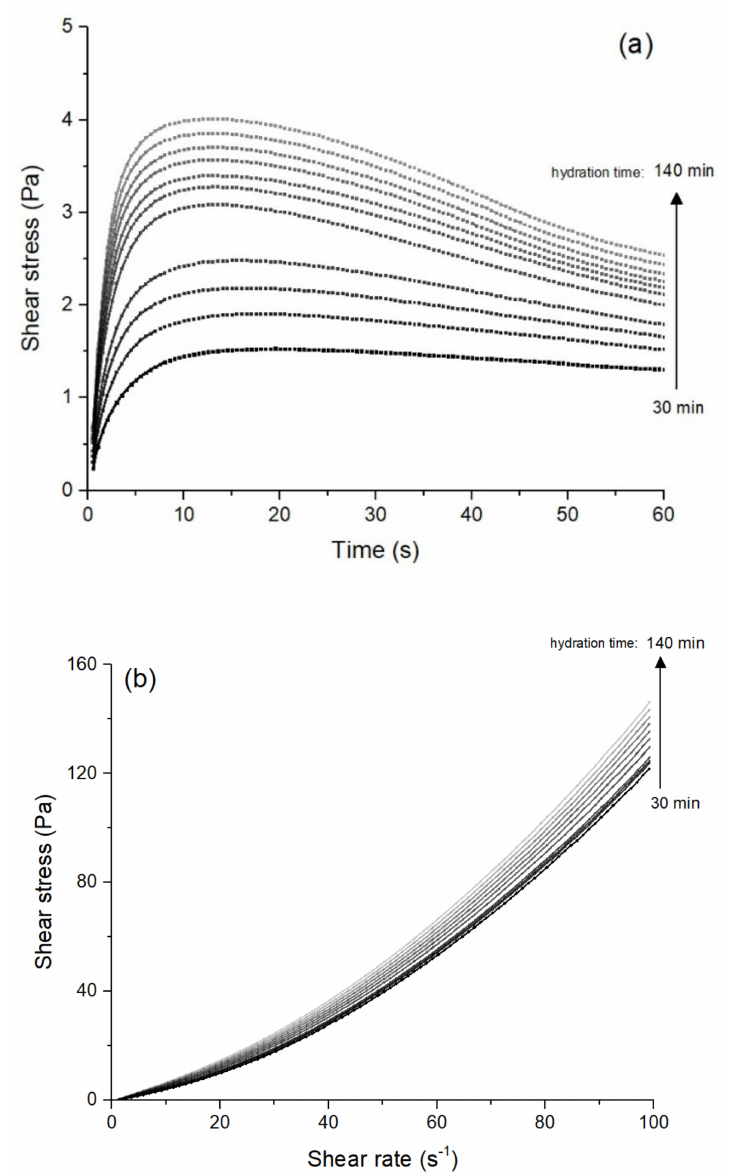
Figure 4. Example of curves obtained in the time-resolved rheological tests for the 0% TiO 2